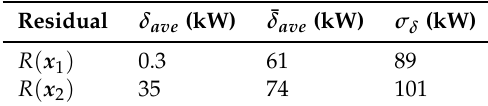
Table 3. Statistical behavior of the residuals between measurements and estimations for the different random choices of the D0 and D1 data sets.